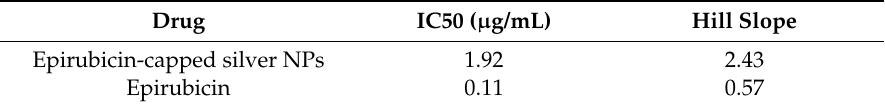
Figure 5. Inhibition curve of ( A ) epirubicin-capped silver NPs and ( B ) epirubicin for the Hep G2 cell line. Table 1. IC 50 and hill slopes of epirubicin-capped silver NPs and epirubicin.